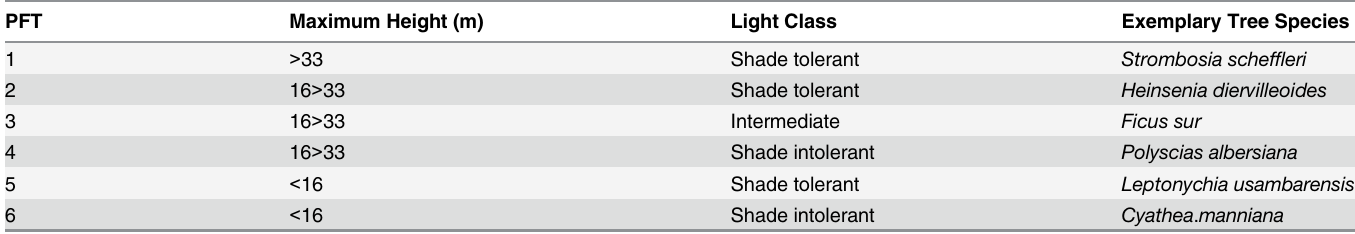
The grouping consists of three size classes and three light demand classes. The size class depends on the maximum attainable height of the respective tree species. The light class indicates shade tolerance: shade-tolerant trees (climax species), shade-intolerant trees (mainly pioneer species) and intermediate shade-tolerant